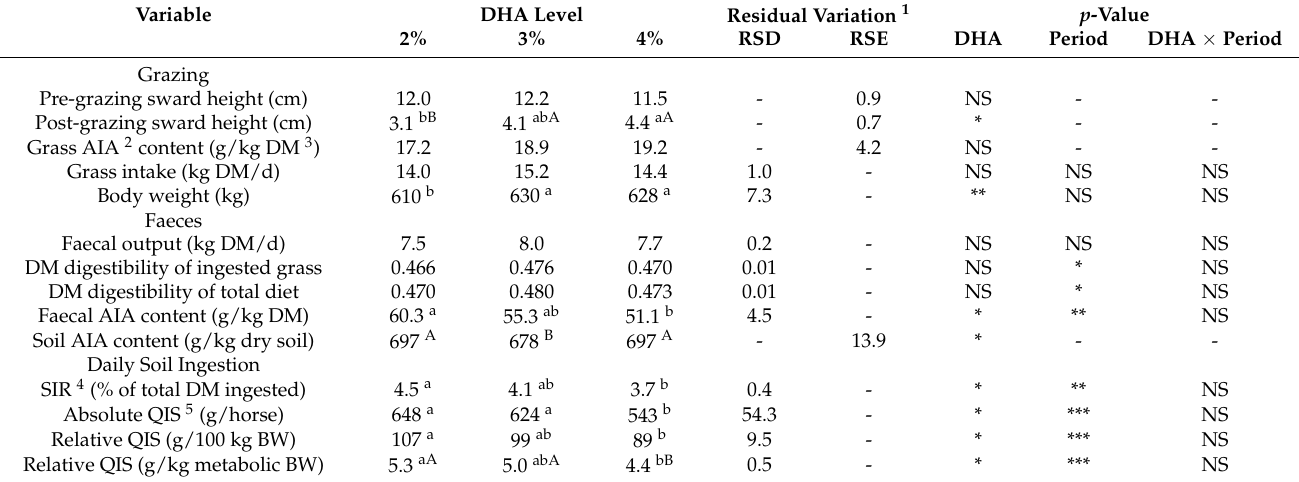
Significance of p -Values for tested effects was <0.05 for *, <0.01 for **, <0.001 for *** and >0.05 for NS (non-significant); a,b Values within a row with different superscripts (lowercase letters) differ significantly at p < 0.05; A,B Values within a row with different superscripts (capital letters) differ significantly at p < 0.1; 1 Mixed models on individual data gave a residual standard deviation (RSD) but simple models on plot data (two animals grazing together) resulted in residual standard error (RSE); 2 AIA: acid insoluble ash; 3 DM: dry matter; 4 SIR: soil ingestion rate; 5 QIS: quantity of ingested